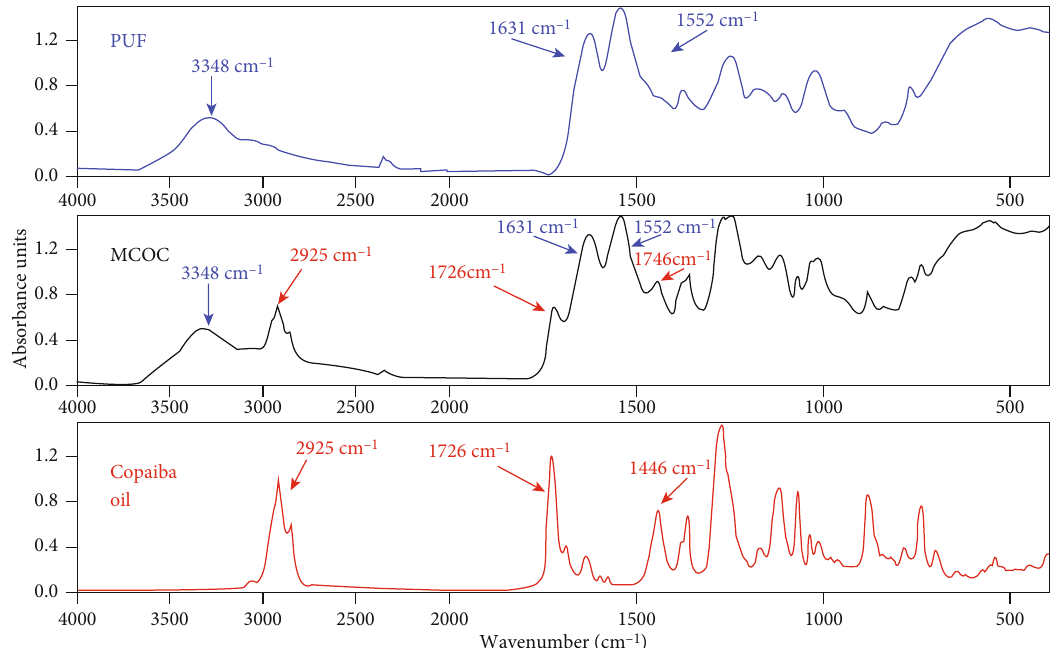
Figure 8: FTIR spectra of the wall material (poly(urea-formaldehyde), the core material (copaiba oil), and the burst microcapsules.